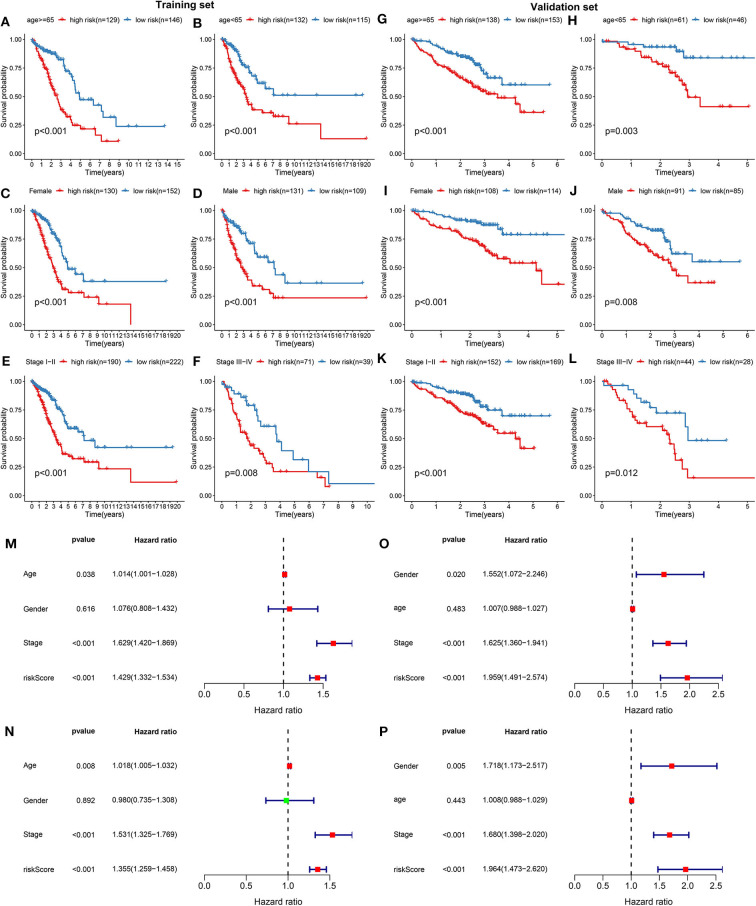
Validation the independency of the risk score based on 13 DNA repair genes for prediction of LUAD prognosis. In the training set, Kaplan-Meier curves depicted the differences on prognosis between high- and low- risk groups in different LUAD subgroups, including (A) ≥65, (B) <65, (C) female, (D) male, (E) stage I-II, and (F) stage III-IV. In the validation set, the differences on prognosis between high- and low- risk groups were confirmed in (G) ≥65, (H) <65, (I) female, (J) male, (K) stage I-II, and (L) stage III-IV subgroups. Univariate and multivariate cox regression survival analysis validated whether age, gender, stage, and risk score could independently predict the clinical outcomes of LUAD patients in the training (M,N) and validation sets (O,P).